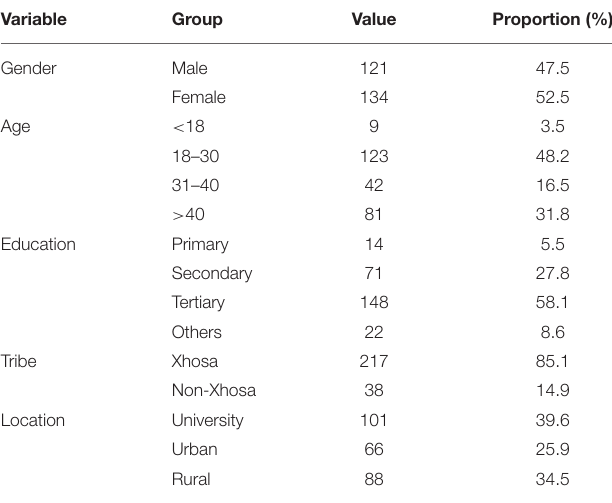
TABLE 1 | Demographic characteristics of the respondents ( n =